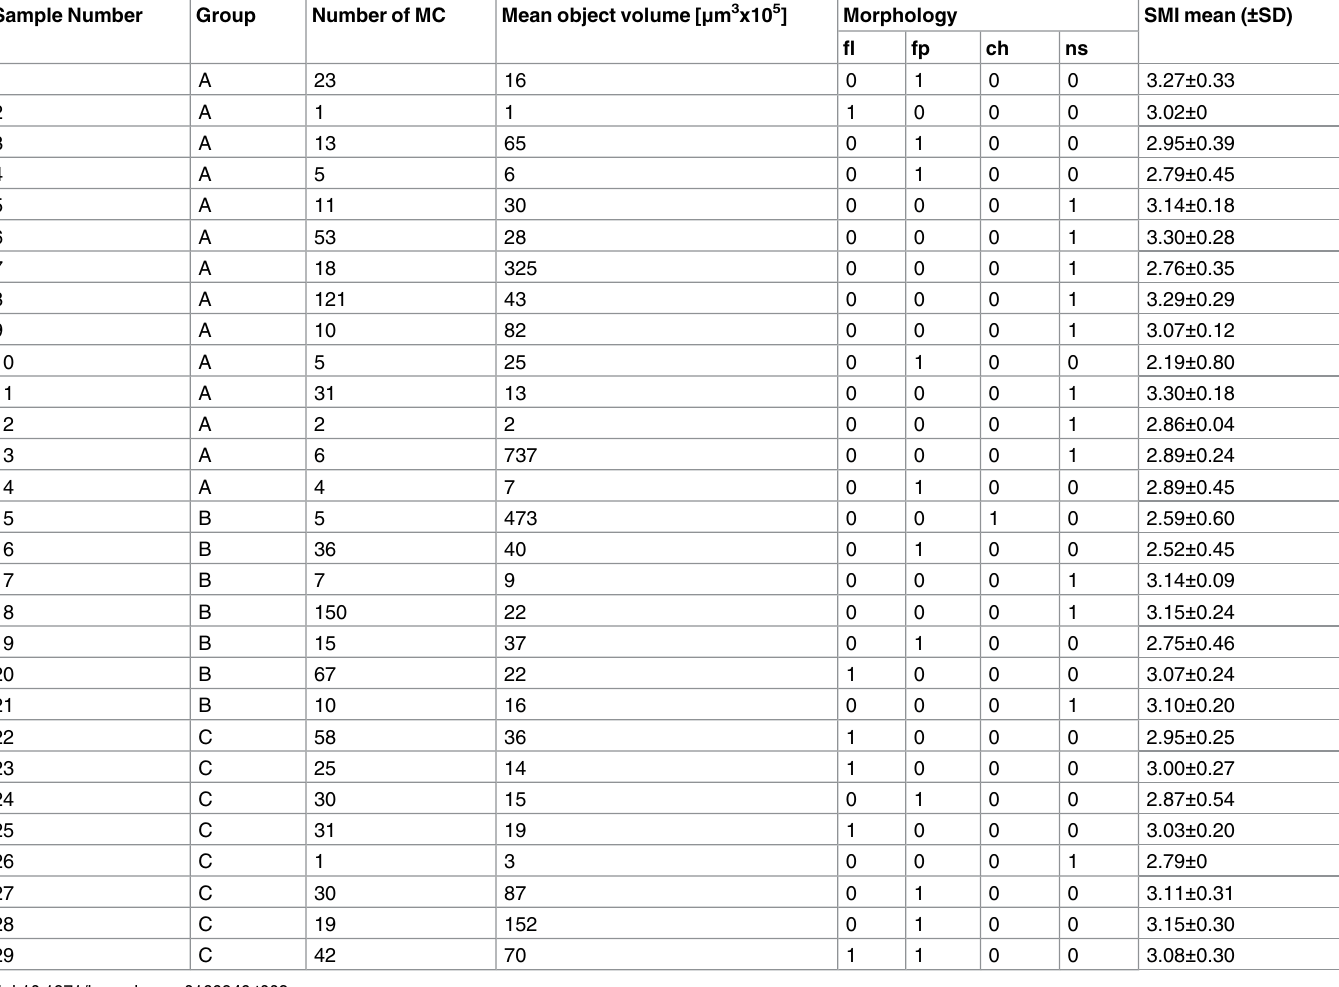
Table 2. Morphological parameters including object volume ( μ m 3 x10 5 ) and the structure model index ( ± SD)of every specimen. Morphology: fl: fine linear, fp: fine pleomorphic, ch: coarse heterogeneous,ns: no suspiciousMC, 1 indicatingpresenceand 0 indicatingabsenceof the respectivetype of microcalcification.